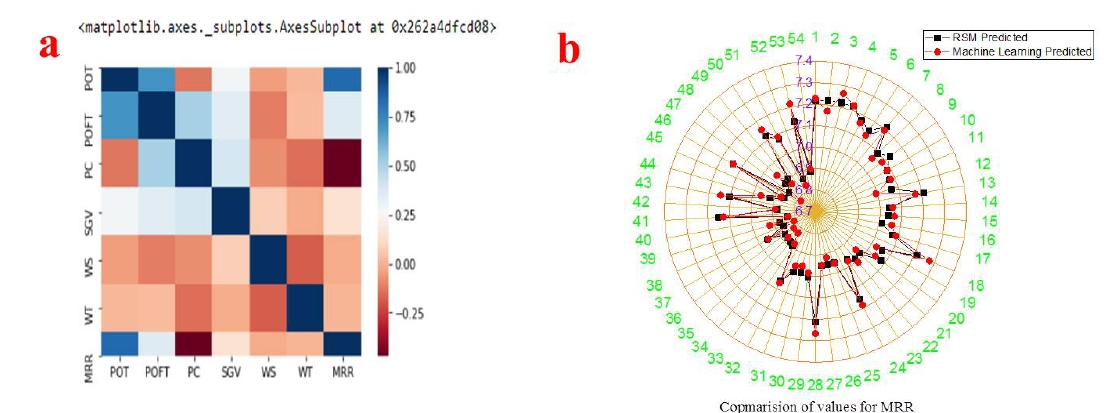
Figure 8: (a) heat map co-relation matrix, (b) Comparison of RSM vs Machine